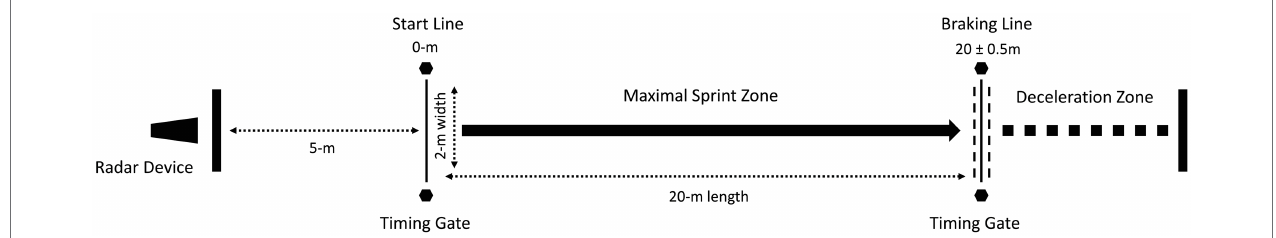
FIGURE 1 | The linear deceleration assessment